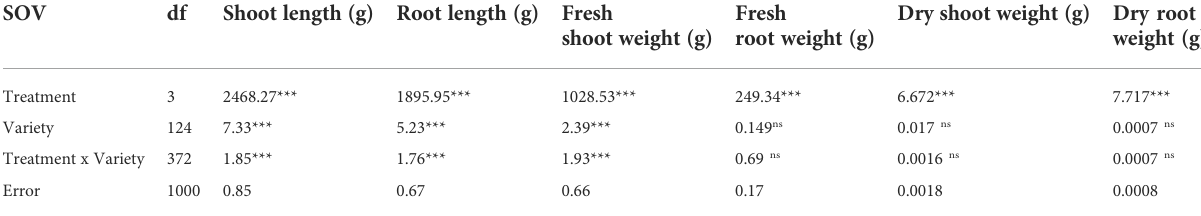
TABLE 1 Mean square calculated through ANOVA for wheat genotypes and salinity treatments. SOV